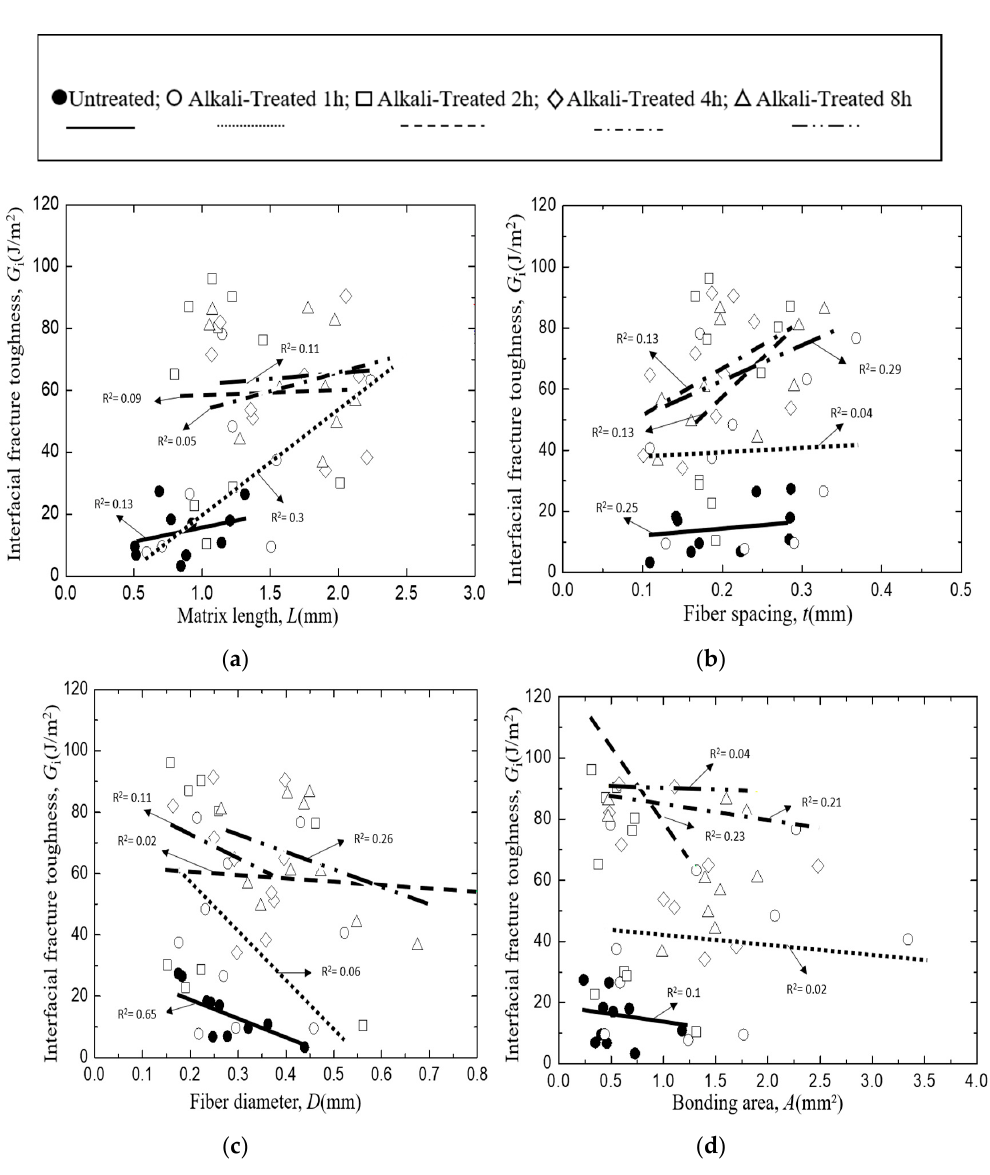
Figure 6. Interfacial fracture toughness of Typha spp. /PLLA, where: ( a ) Matrix length, ( b ) Fiber spacing, ( c ) Fiber Diameter, ( d ) Bonding area.